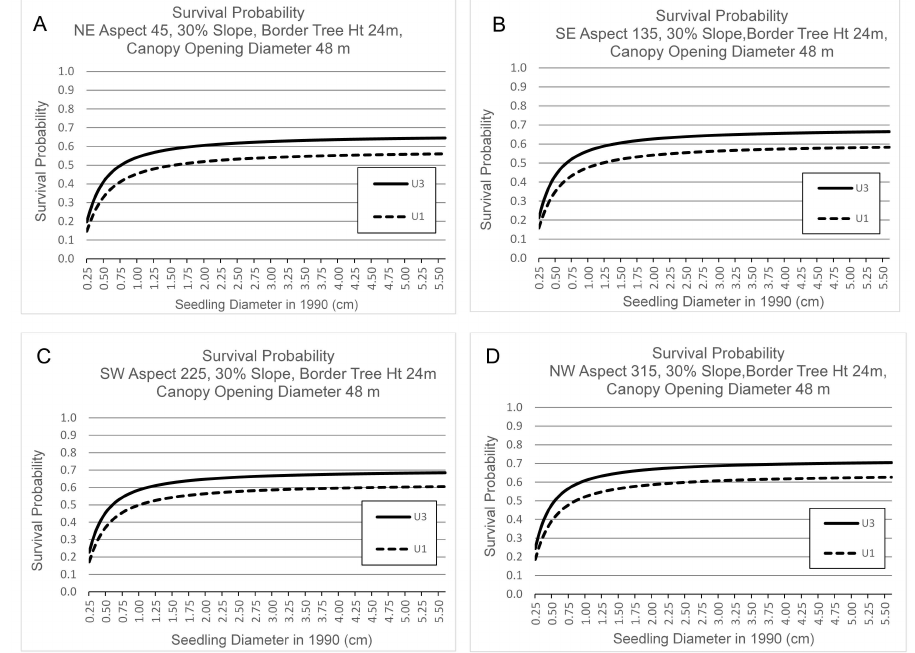
Figure 3. The relationship between seedling diameter, survival probability and understory treatment (U3 is understory treatment with an herbicide applied to cut stems, U1 refers to no understory treatment). ( A )–( D ) With 30% slope, canopy border tree height of 24 m, and canopy opening diameter of 48 m. ( A ) Northeast aspect. ( B ) Southeast aspect. ( C ) Southwest aspect. ( D ) Northwest